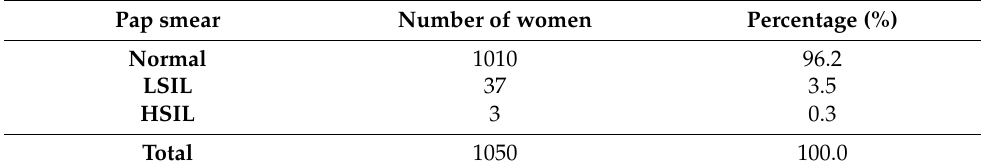
Table 3. Distribution of women according to cytological findings—Pap smear ( N =